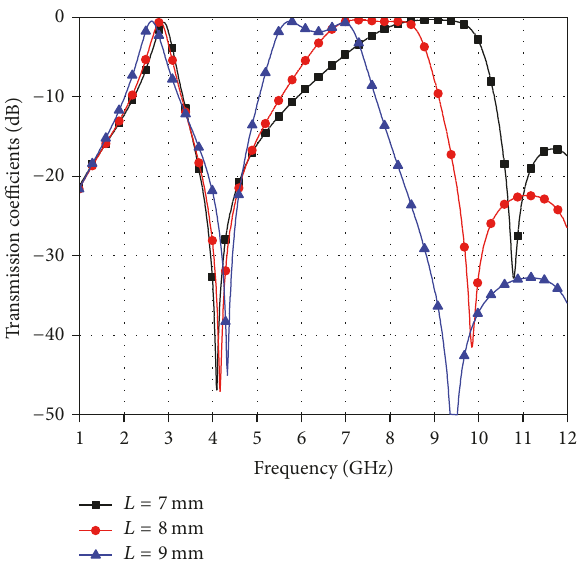
Figure 8: Transmission coefficients of the dual-band FSS with the different size of the patches.